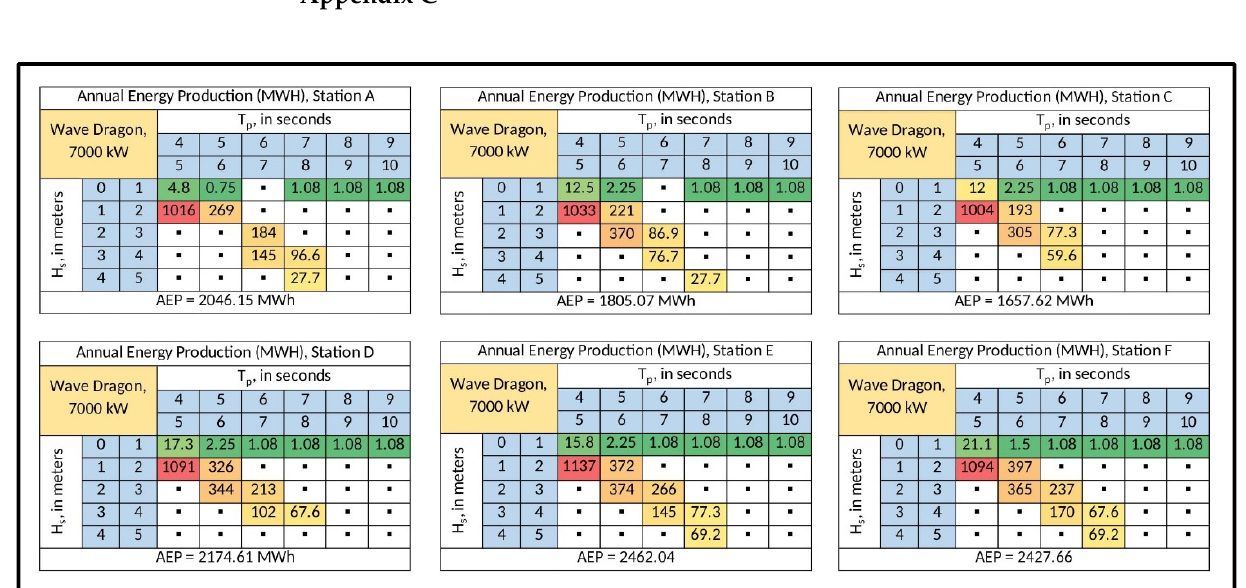
Figure A3. AEP computations of WD7 for stations A–F.